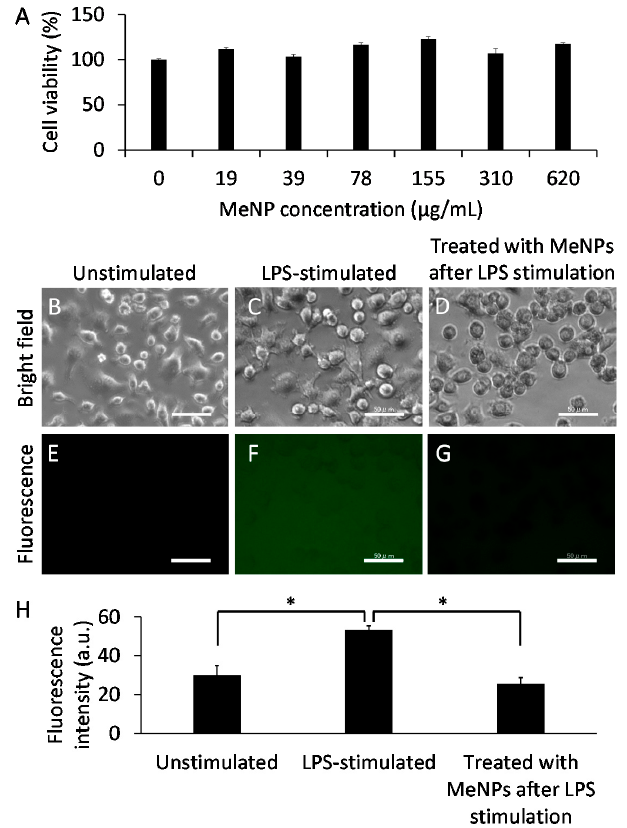
Figure 3. ( A ) The cytotoxicity of MeNPs in KCs. ( B – D ) Bright-field and ( E – G ) fluorescence images of KCs (scale bar 50 μ m). Hydroxyl radicals in the medium were detected using APF. ( B , E ) Unstimulated and ( C , F ) LPS-stimulated KCs. ( D , G ) KCs treated with 6.2 μ g mL − 1 MeNPs after LPS stimulation. ( H )